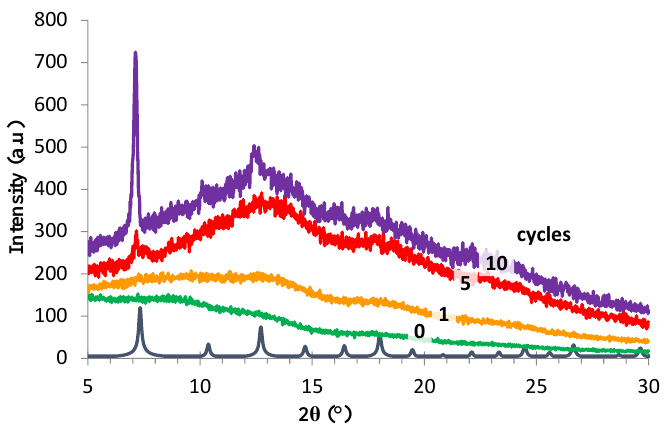
Figure 3. Wide angle powder XRD patterns of neat PIM-1 (green), and PIM-1-supported ZIF-8 membrane after 1 cycle (orange), 5 cycles (red) and 10 cycles (purple). Simulated ZIF-8 is shown for comparison (blue).